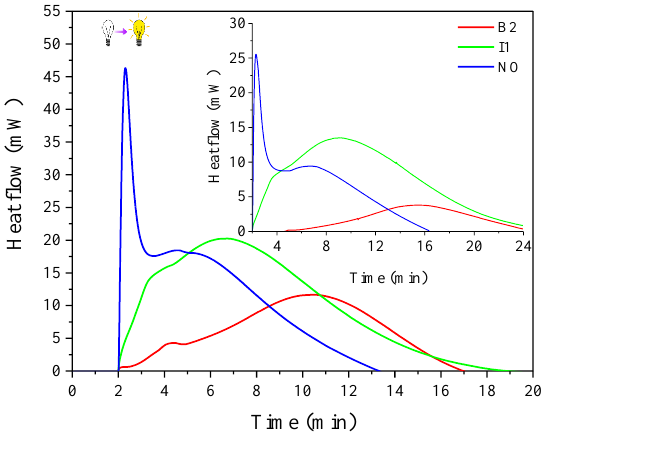
Figure 18. Normalized absorption ( L ) and fluorescence ( R ) spectra of BPSQ2 registered in solvents of various polarities at room temperature. Reproduced from ref. [114], with permission from The Royal Society of Chemistry, 2022. The proposed sensitizers in combination with a suitable co-initiator, i.e., tetramethy- lammonium n -butyltriphenyl borate (B2), diphenyliodonium chloride (I1) or 1-methoxy-4- phenylpyridinium tetrafluoroborate (NO), give a highly active photoinitiating system for radical polymerization of trimethylolpropane triacrylate (TMPTA), as shown in Figure 19. The most effective PISs contained 1 × 10 − 3 M of photoinitiator. It has been found that further increasing of the amount of initiator decreases the rate of polymerization, what may be explained by the inner filter effect. It means that a high concentration of a strongly absorb- ing dye molecule decreases the penetration of light into deeper layers of the polymerizable formulation, which causes a slowing down or total inhibition of the polymerization reaction.